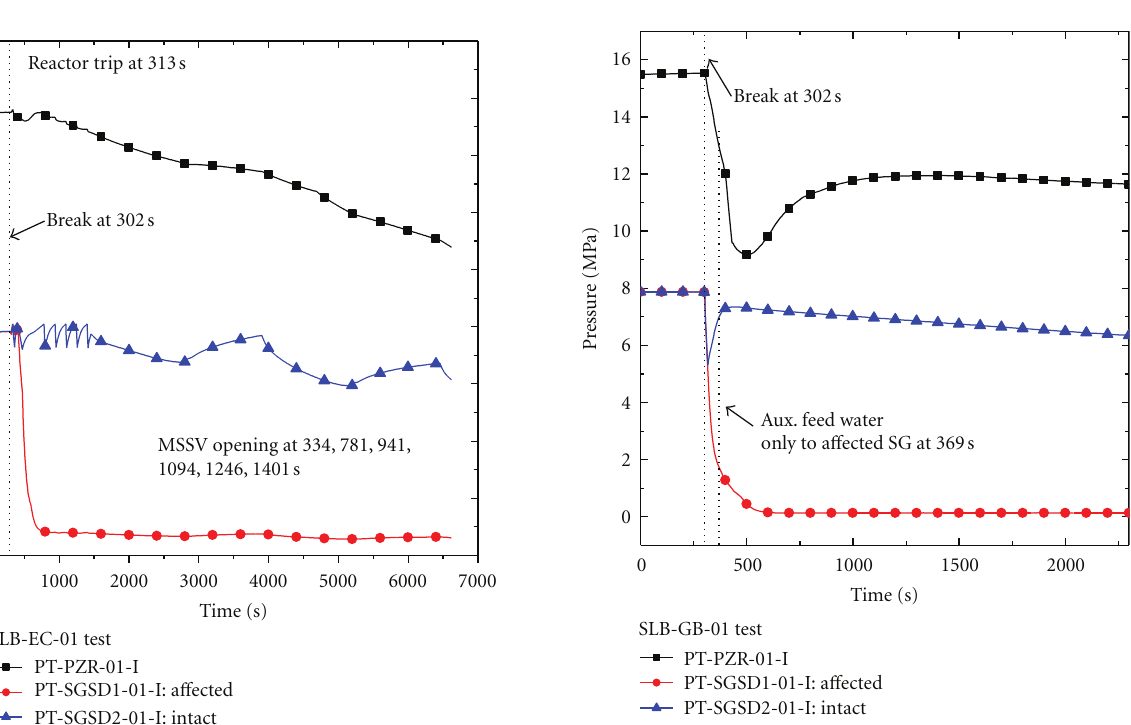
Figure 26: Pressure trends at the pressurizer and steam generator dome.